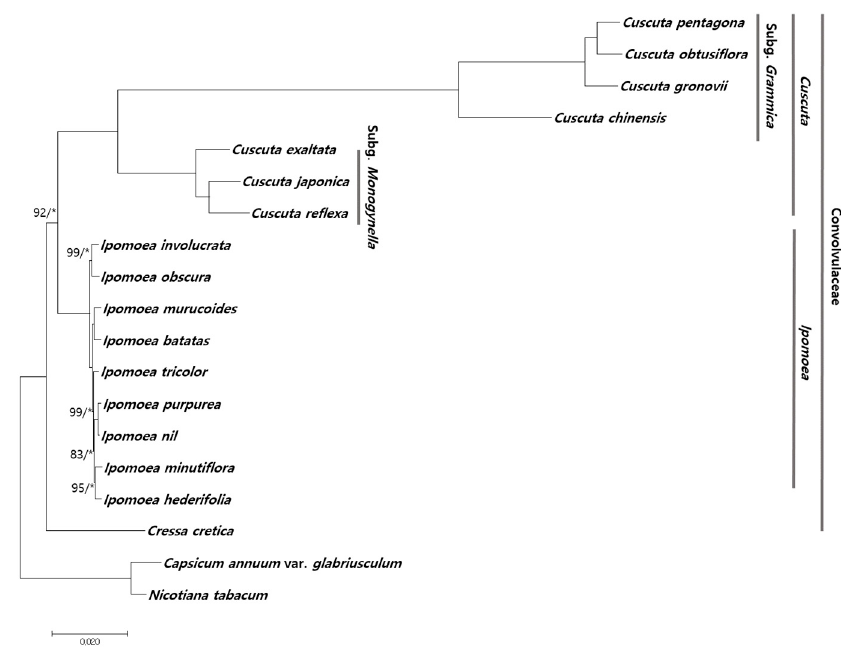
Figure 4. Phylogenetic analysis of Cuscuta and Ipomoea species. The phylogenetic tree was constructed with the maximum likelihood (ML) method and Bayesian Inference (BI) using 50 conserved protein-coding sequences from seven Cuscuta species, nine Ipomoea species and Cressa cretica within the family Convolvulaceae. Capsicum annuum var. glabriusculum and Nicotiana tabacum were used as outgroups. ML topology is shown with bootstrap (BS) values and Bayesian Inference (BI) posterior probability (PP) values at each node. BS = 100% and PP = 1.0 are not marked. * was shown 1.0 PP